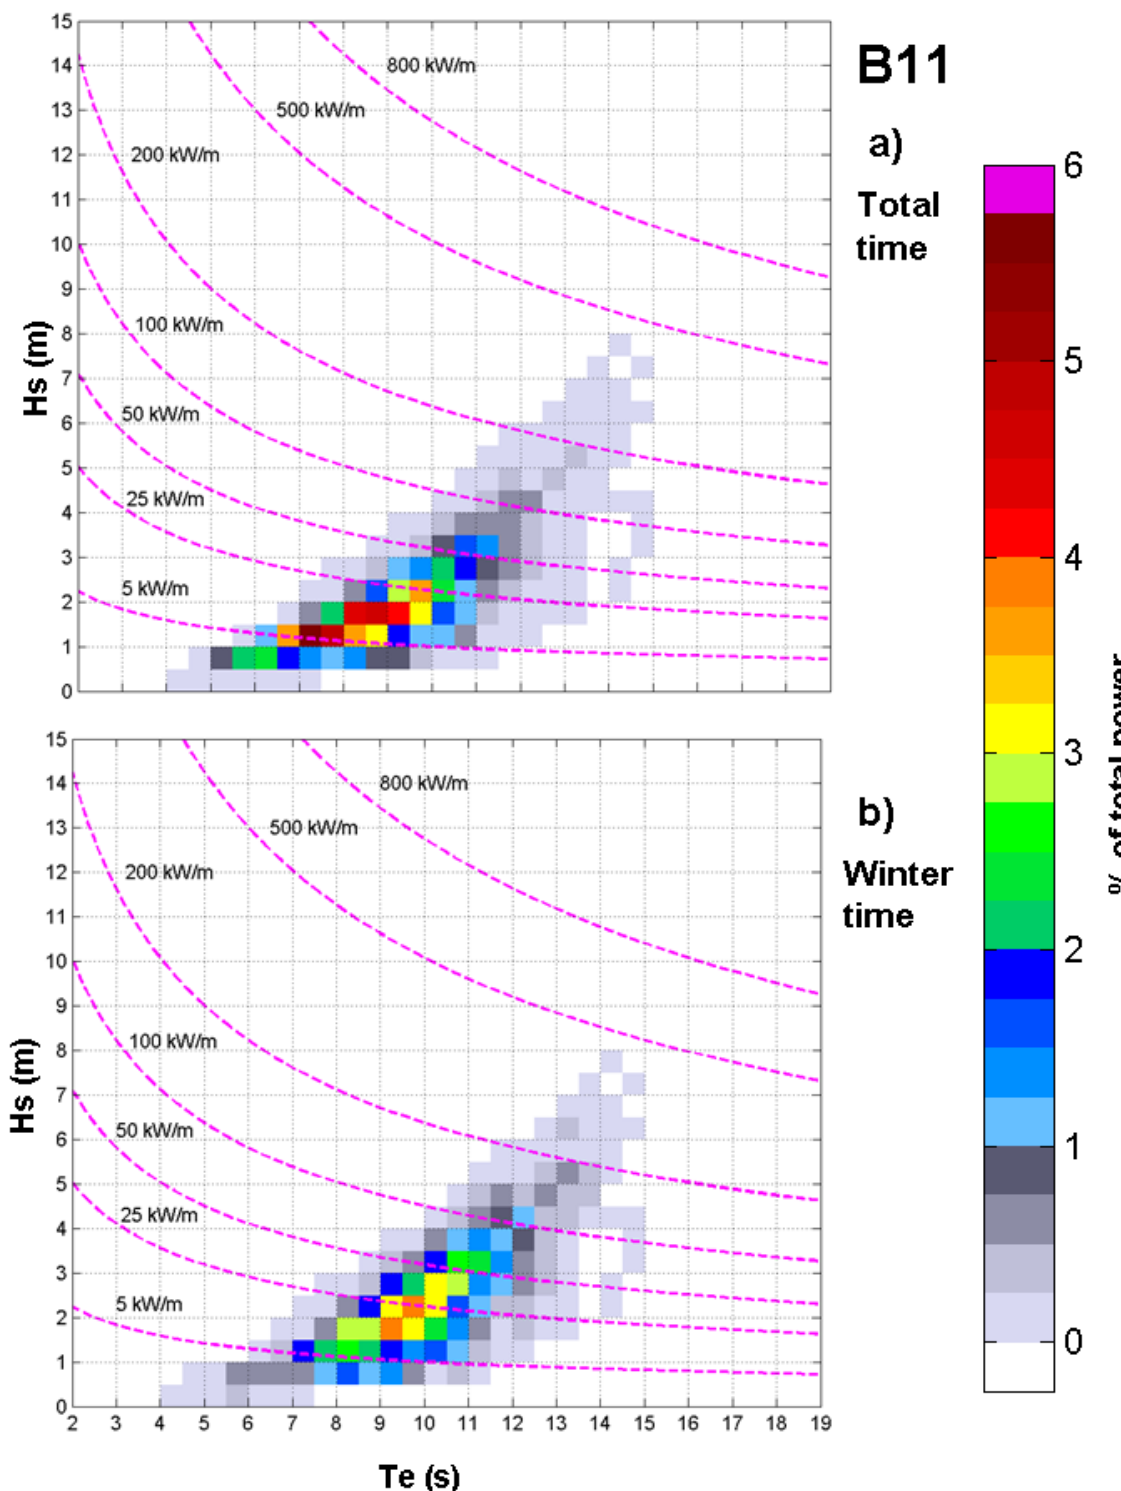
Figure 4. Reference point B11 (P6 offshore); bivariate distributions of occurrences corresponding to the sea states defined by H 2009–2011. The color scale is used to represent the contribution of the sea state to the total incident energy, as a percentage. The wave power isolines are also represented. ( a ) Total time; ( b ) Winter